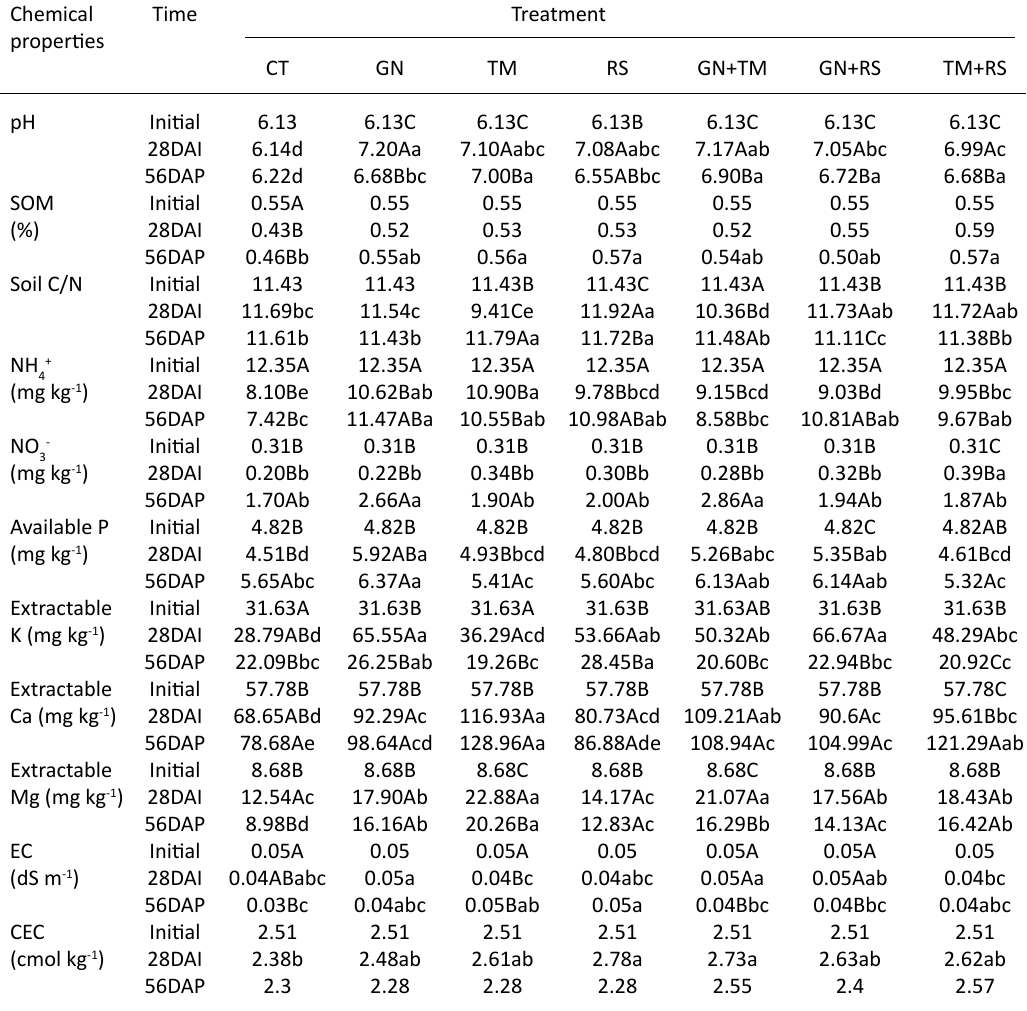
Table 3. Chemical properties of the soils at initial stage, 28 days of incubation and 56 days after planting of maize Chemical Time